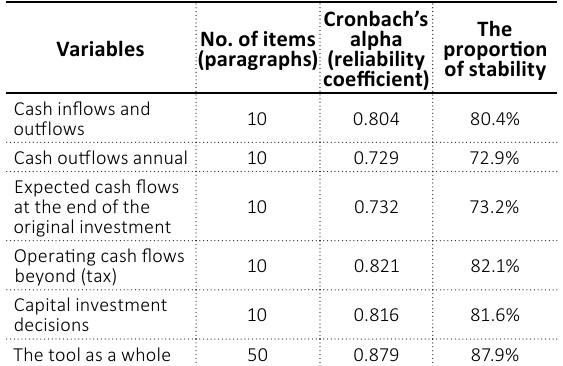
Table 3. Reliability of the results (internal consistency of the questionnaire items)